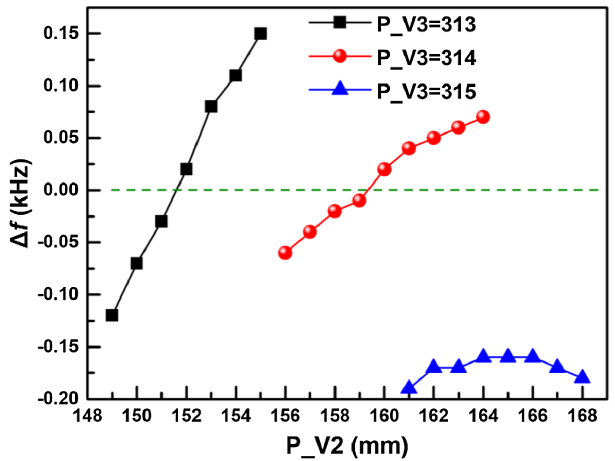
FIG. 23. Position influences of channels V2 and V3 on Δ f